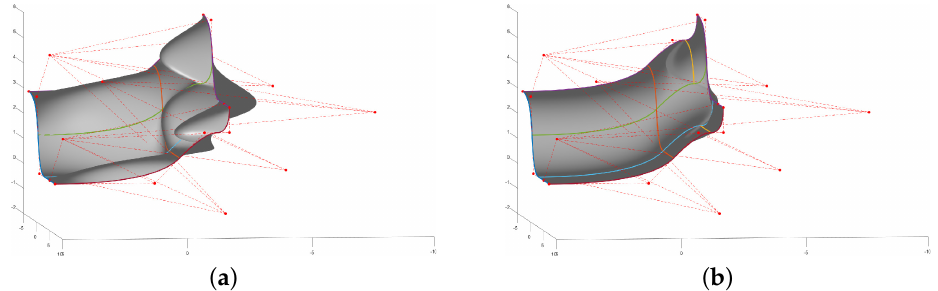
0,0,0, 1 , 2 ,1,1,1 and 3 3 { }